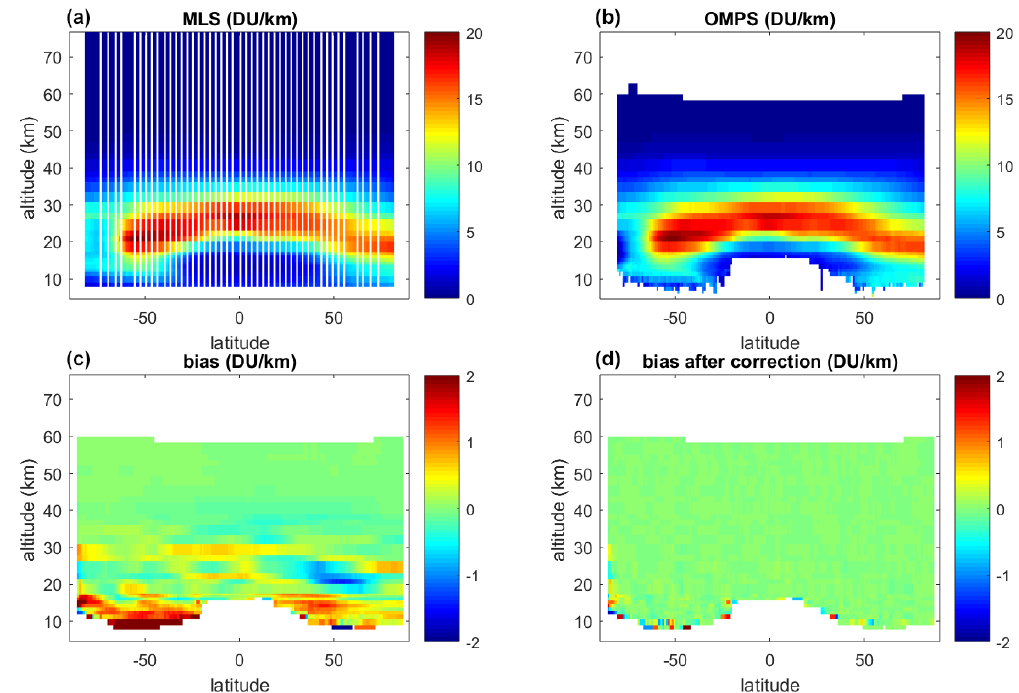
Figure 6. Illustration of the bias correction for September 2018. (a, b) MLS and OMPS profiles averaged over latitude zones and over the month. (c, d) Estimated OMPS biases before (c) and after (d) bias correction.